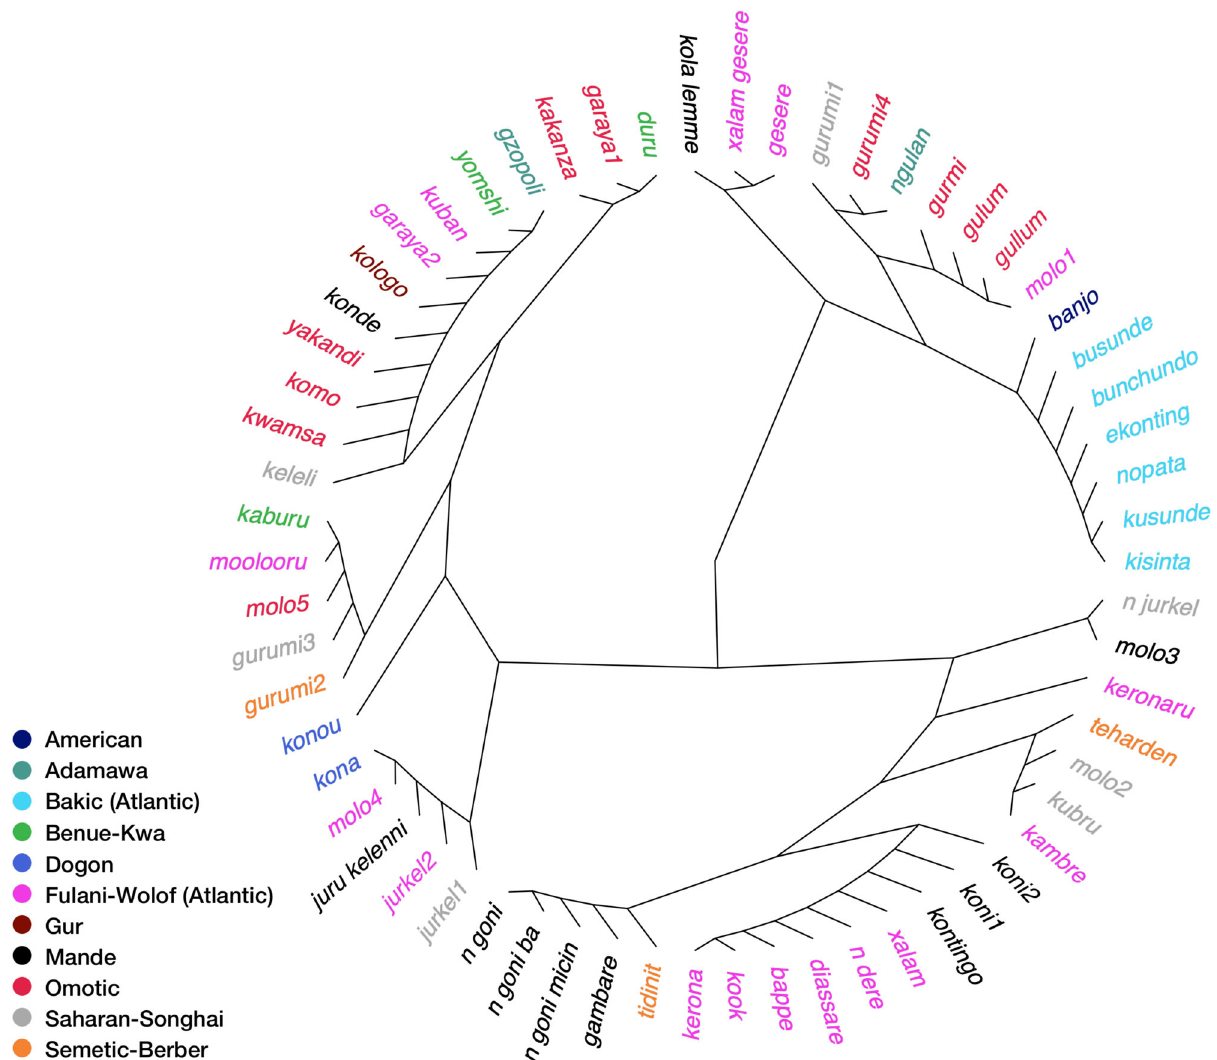
Fig. 4 Dendrogram by language. UGPMA dendrogram of instruments, labeled by language group (Saharan-Songhai language groups and Berber-Semitic language groups each combined for plotting clarity). Tip labels follow the instrument names in the taxon character matrix (SI